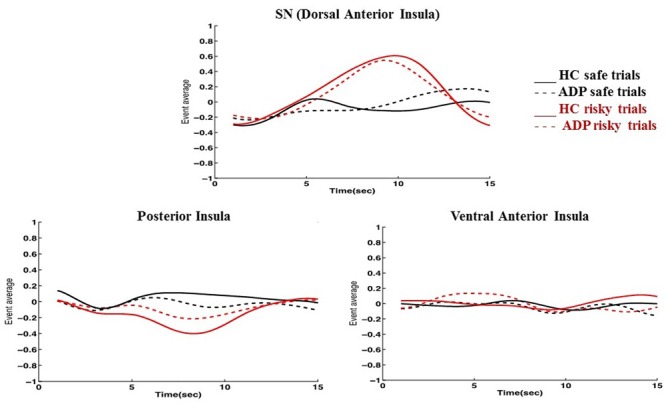
Graphs depicting how the insula networks are engaged for each trial type across the duration of a trial indicate several key findings. (1) The SN/dorsal anterior insula is engaged more in risky trials (LP) than safe trials (NP) by both HC and ADP; (2) The posterior insula network exhibits the inverse behavior and is more engaged for safe trials (NP) than risky trials (LP) by both HC and ADP; (3) ADP show a dampened but similar pattern of SN engagement in risky trials compared to HC during anticipation; (4) ADP show over-engagement of the posterior insula network compared to HC during risky trials (LP) at anticipation (5) The ventral anterior insula network does not show significant changes in engagement during any of the trial conditions.